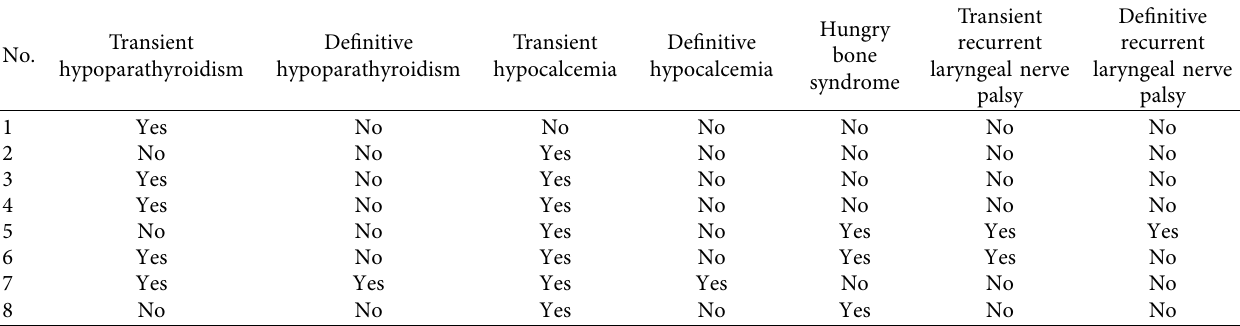
Table 3: Postoperative complications of 8 patients affected with